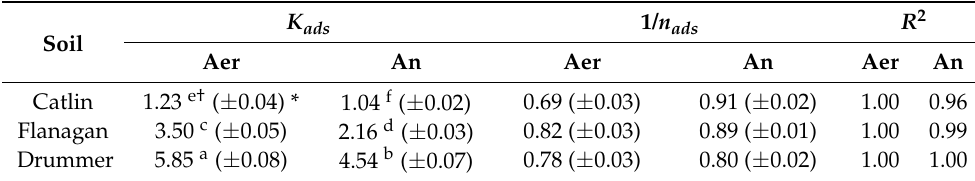
Table 2. Adsorption (Freundlich model) of 14 C-metolachlor in different soil types under aerobic (Aer) and anaerobic (An) environmental